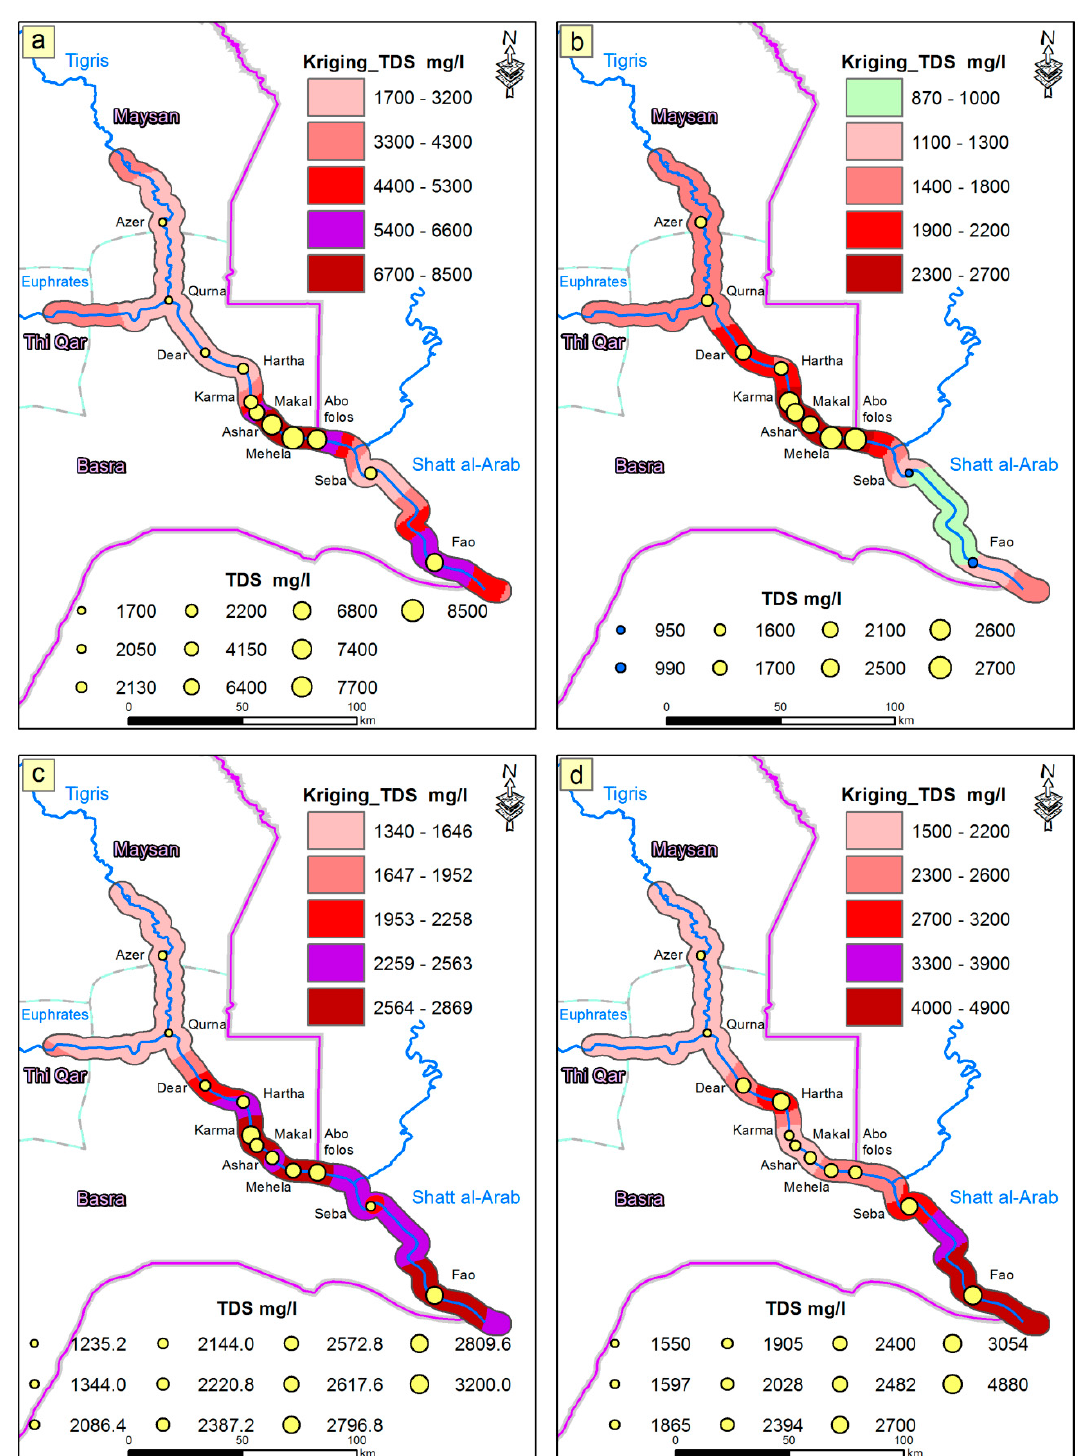
Figure 5. Spatial distributions of TDS concentrations using kriging interpolation: ( a ) winter 2018, ( b ) spring 2019, ( c ) summer 2019, and ( d ) autumn 2019.